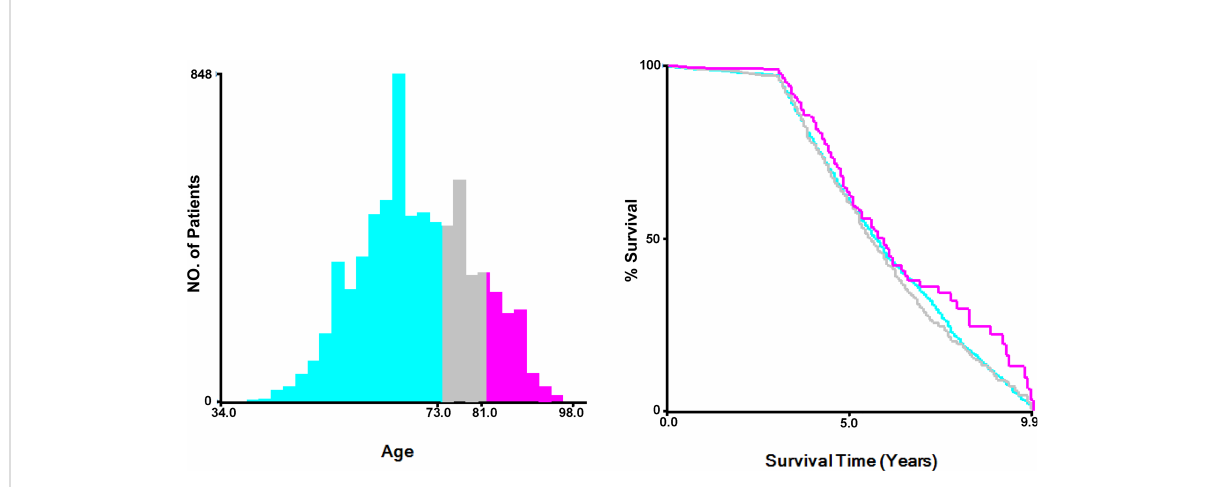
FIGURE 2 Determination of the optimal cut-off values of age at diagnosis by